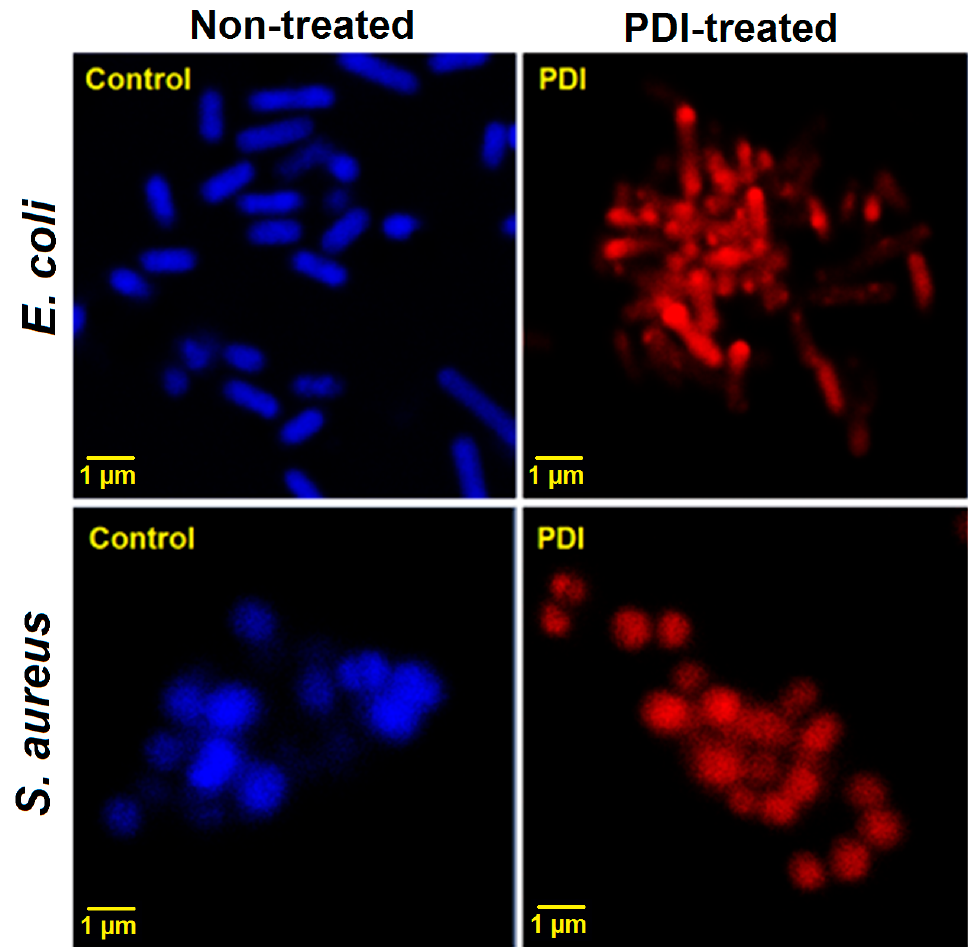
Figure 12. Laser scanning confocal microscopy images of non-treated and PDI treated (2 h incubation, 10 J / cm 2 , 420 ± 20 nm LED light, material concentration at 0.5 g / L) Escherichia coli and Staphylococcus aureus stained with Hoechst33342 (live, blue fluorescence) and PI (dead, red fluorescence).